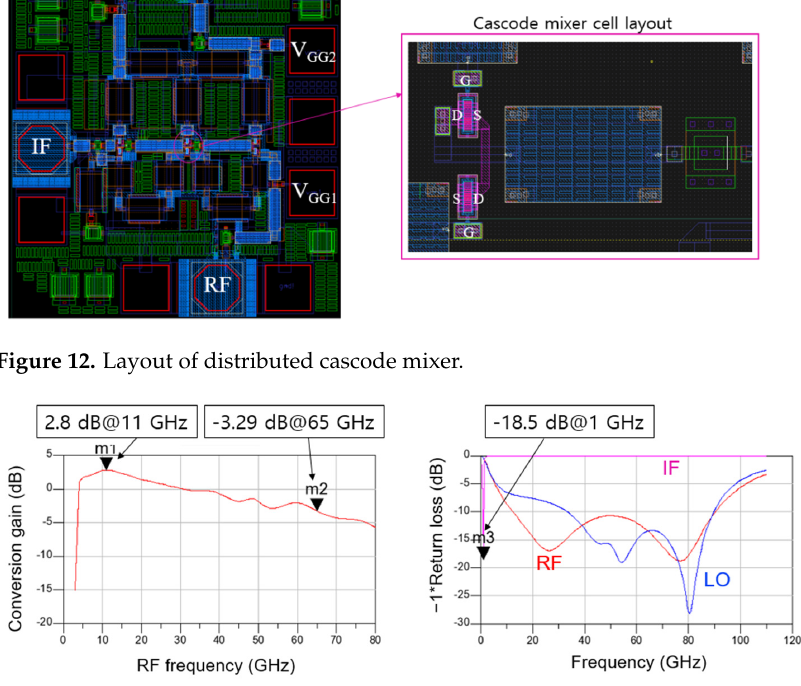
Figure 12. Layout of distributed cascode mixer.